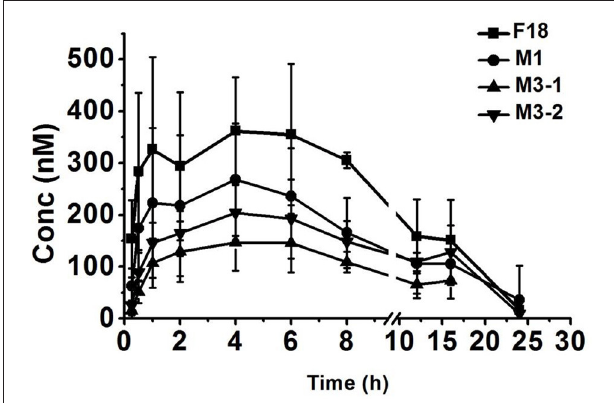
FIGURE 7 | Mean blood concentration-time profiles of F18, M1, M3-1, and M3-2 in rats after oral administration of F18 at dose of 50 mg/kg ( n = 5). The data are presented as the means ± SD. Conc., Concentration.